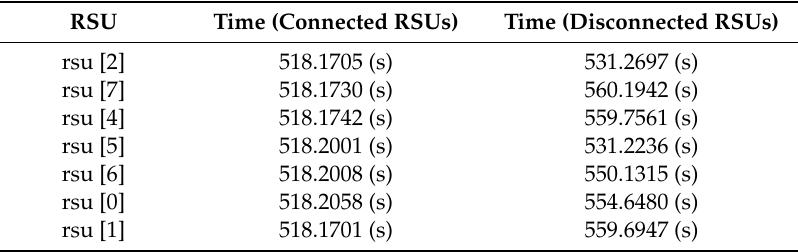
Table 4. RSU starts sending the